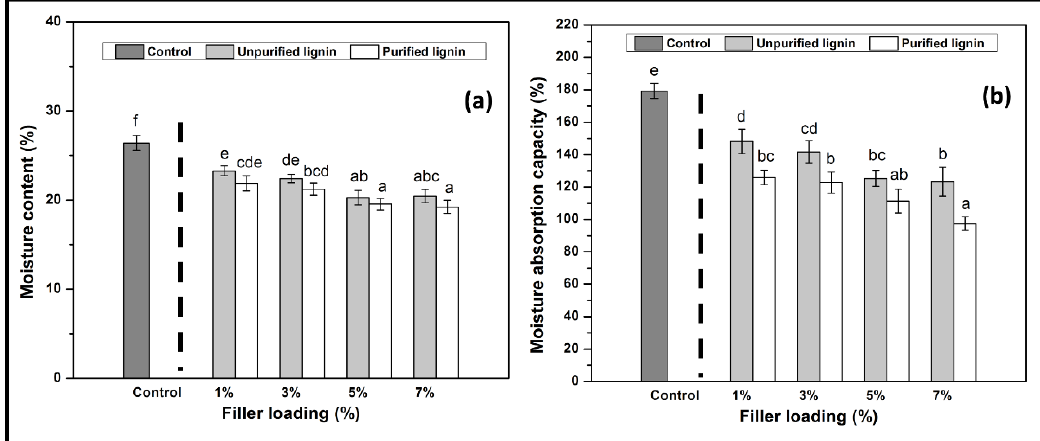
Figure 3. Physical properties of ( a ) moisture content and ( b ) moisture absorption capacity of LNPs/macroalgae biopolymer films. Mean values are plotted with one standard deviation error bar. The letters (a, ab, abc, b, bc, bcd, cd, cde, d, de, e) above data bars indicate no significant difference in the values ( p < 0.05) analysed by ANOVA test.